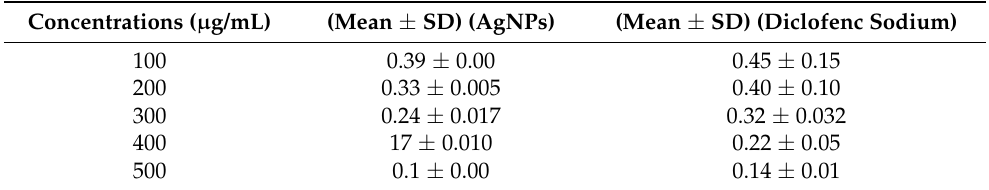
Figure 9. Graphical representation of percentage inhibition of albumin denaturation by BP-AgNPs and standard drug diclofenac sodium. Values are represented in (Mean ± SD) and significant level ( p < 0.05), through one-way ANOVA. Table 4. Values represented in (Mean ± SD) and significant level ( p < 0.05), through one-way ANOVA of protein denaturation assay.